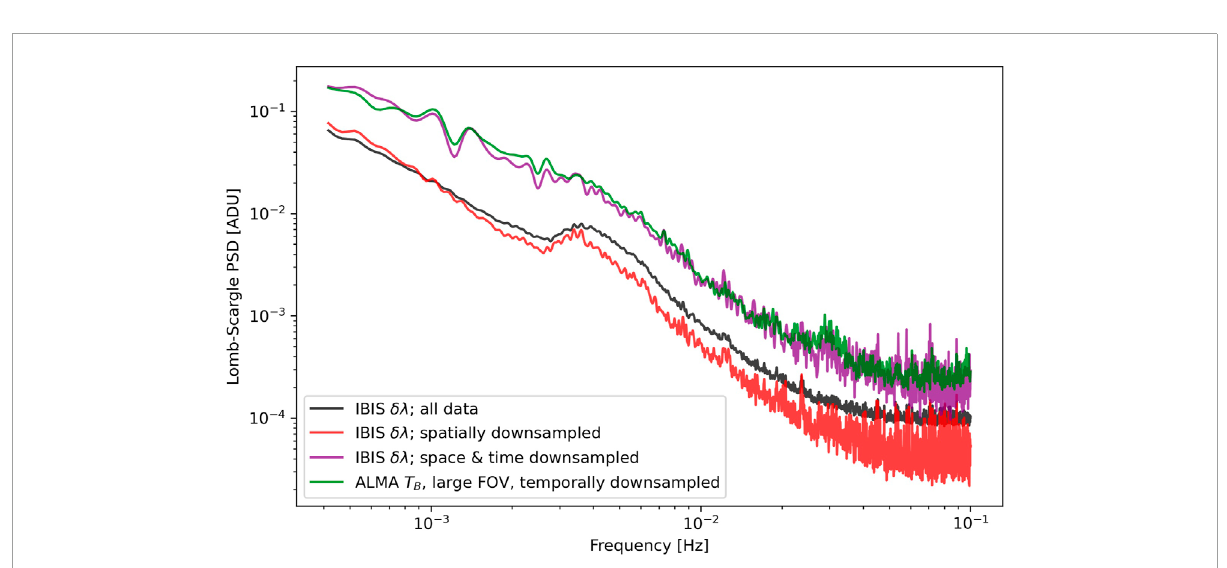
FIGURE 7 Spatially averaged power spectra for different sub-samples of data series. All IBIS line width data (black); spatially down sampled IBIS line width (red); spatially and temporally down sampled IBIS line width (purple); ALMA temporally down sampled temperature 67 ′′ FOV (green).